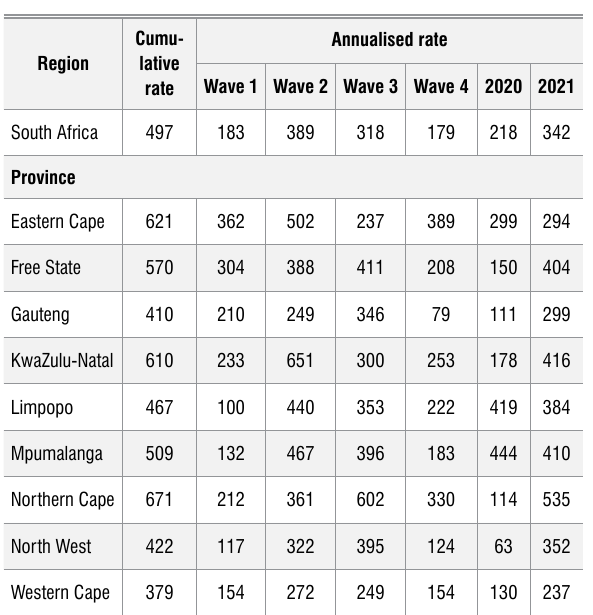
Table 2: Age-standardised cumulative excess death rate (per 100 000 population) and annualised excess death rate (per 100 000 population) by wave and year for provinces of South Africa.